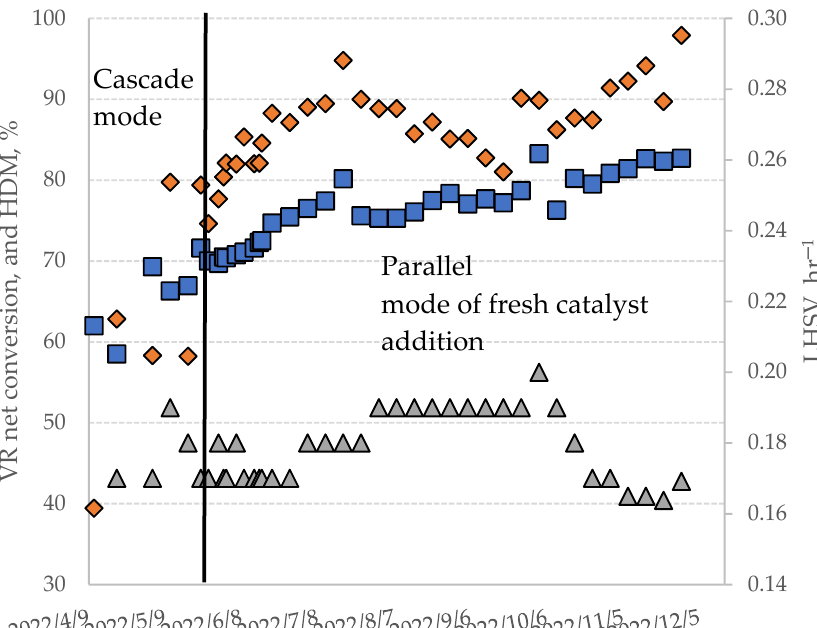
Figure 8. Variation of HDM, net conversion, and LHSV during the investigated period.